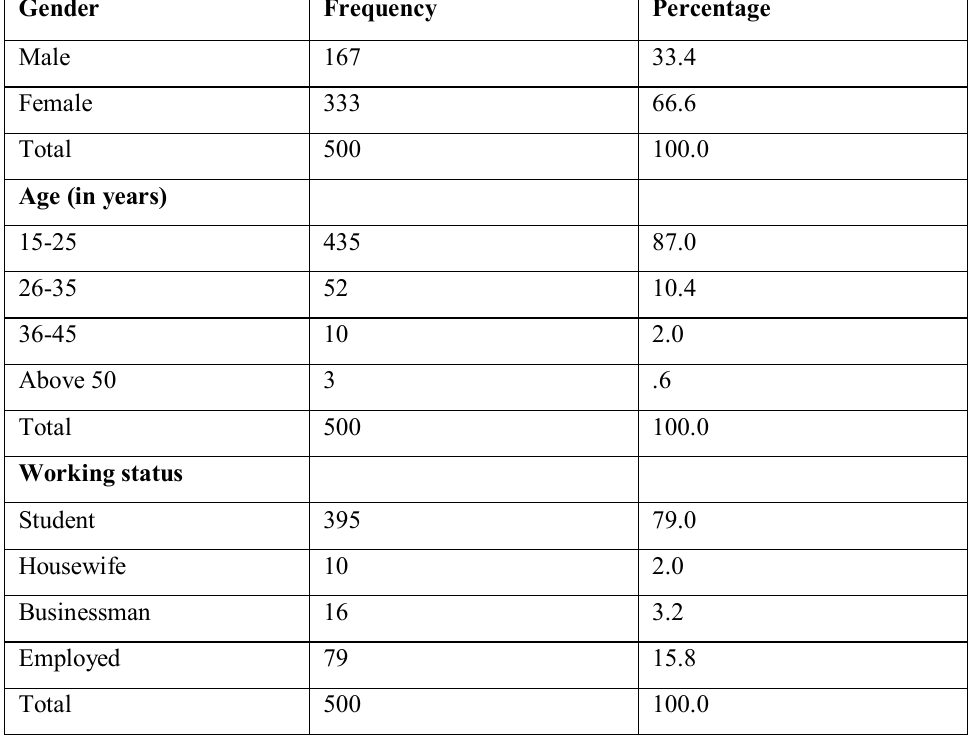
Table I (Brief summary of Table I: 33.4 percent of the respondents were male, while a majority i.e. 66.6 percent of them were females, 87.0 percent of the respondents had age 15-25 years, while 10.4 percent of them had 26-35 years, 2.0 percent of them had 36-45 and only 0.6 percent of them had above 50 years of age. 79.0 percent respondents were students, while only 2.0 percent of them were housewives, 3.2 percent of them were businessmen and 15.8 percent